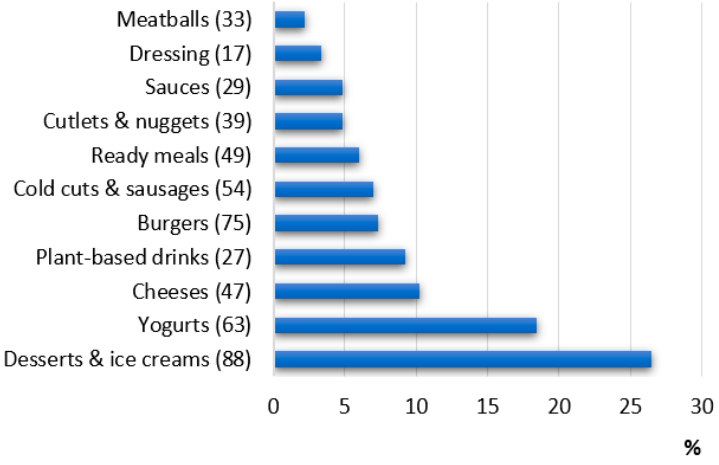
Figure 5. Prevalence of additive-containing products in the categories of processed plant-based products. The total number of analyzed products per category is reported in brackets.